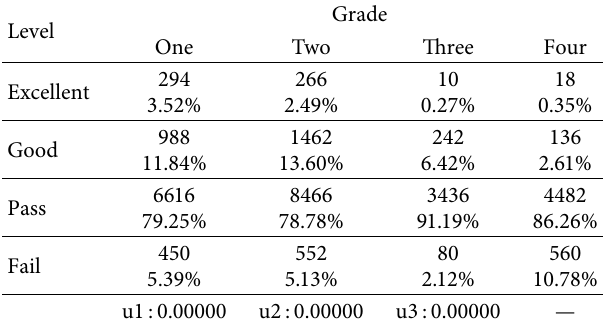
Table 2: Performance and grade ratio of girls’ 50m race.